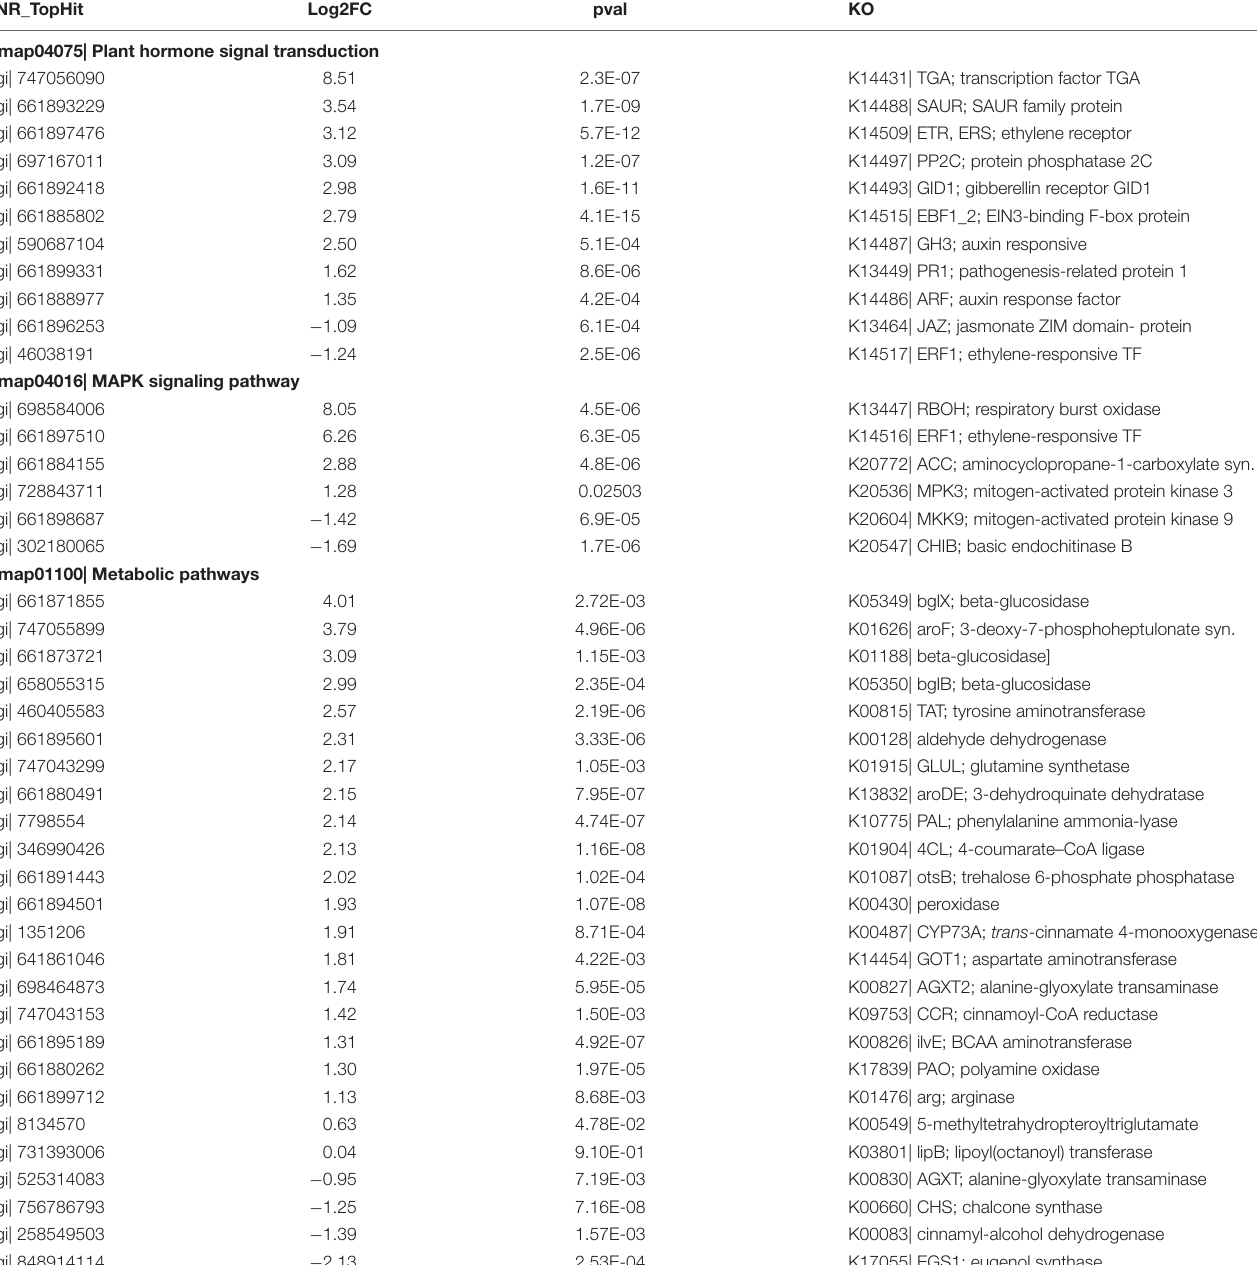
TABLE 3 | Differentially expressed genes (DEGs) selected in the leaves of S. argel plants under salt stress conditions. NR_TopHit Log2FC pval KO map04075| Plant hormone signal